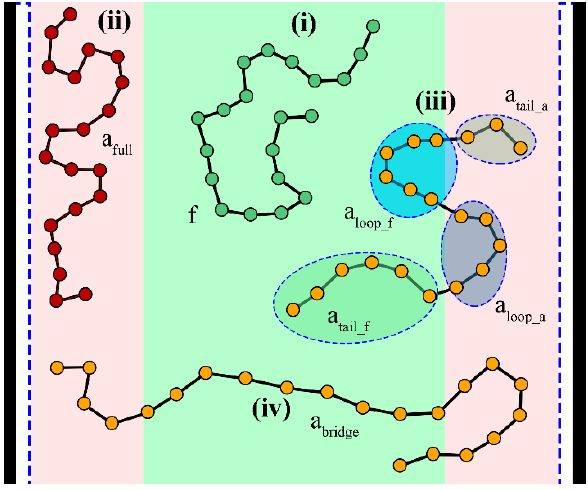
Figure 9. Schematic illustration of (i) a free chain, f, (ii) a fully adsorbed chain to the left surface, a − , (iii) a partially adsorbed chain at the right surface, a + , which features loops and tails outside (a + ,a + ) and inside (a + ,a + ) the adsorption region, and (iv) a chain that is partially adsorbed on both surfaces, which forms a bridge, a bridge .